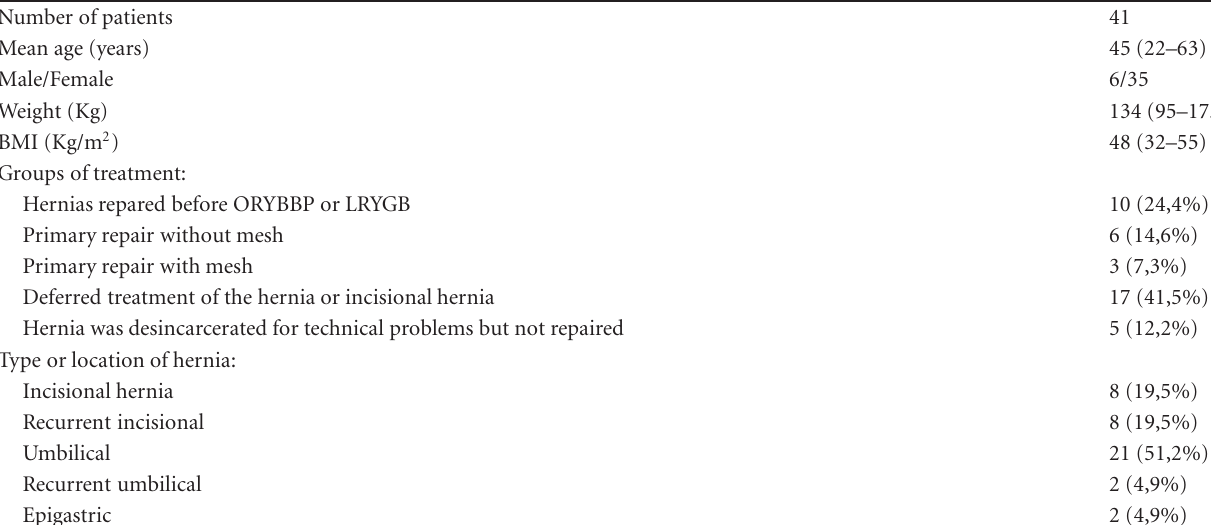
Table 2: Characteristics of the patients with hernia or incisional